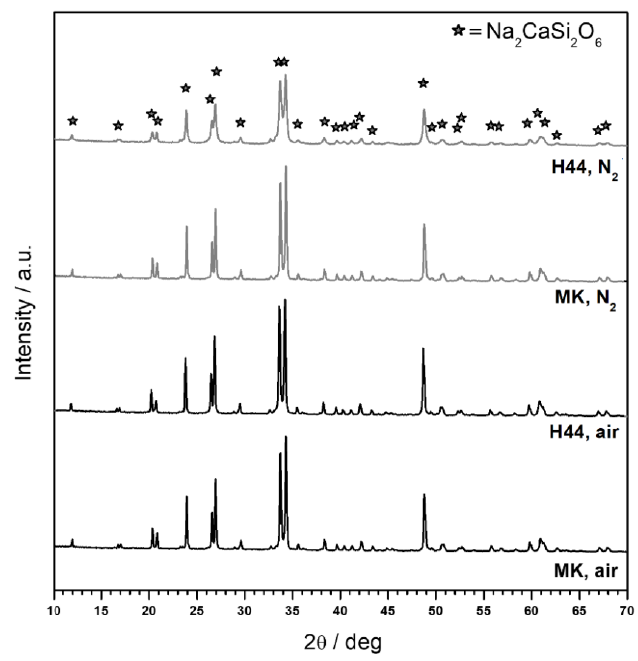
Figure 3. X-ray diffraction analysis of polymer-derived Biosilicate ® -like scaffolds: comparison of formulations (MK: ink based on MK silicone; H44: ink based on H44 silicone) and firing atmosphere.